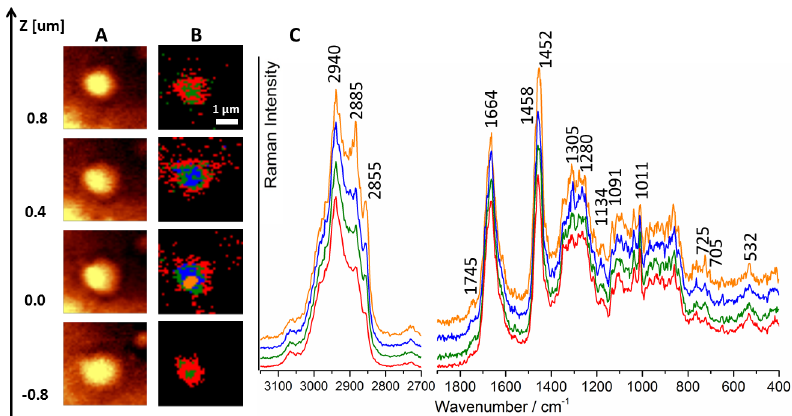
Figure 3. Depth profiling of the lipid raft. Raman distribution images (integration over the band in the 2800–3100 cm 2 1 range) at different depths (denoted by z value, the layer marked as z=0.0 m m was chosen by maximizing the Raman intensity signal, A ), Cluster Analysis of the corresponding images ( B ) with the averaged spectra of classes ( C , spectra were normalized to the 1011 cm 2 1 band and offset in order to emphasize the differences between them, the Raman intensity in the 2700–3200 cm 2 1 range is 3.5-fold magnified relatively to the fingerprint region). doi:10.1371/journal.pone.0106065.g003 samples of db + (control, Fig. 4A) and db/db (T2DM, Fig. 4B, C) mice showed striking differences between the tissue area covered by LRs in T2DM relatively compared to the control.